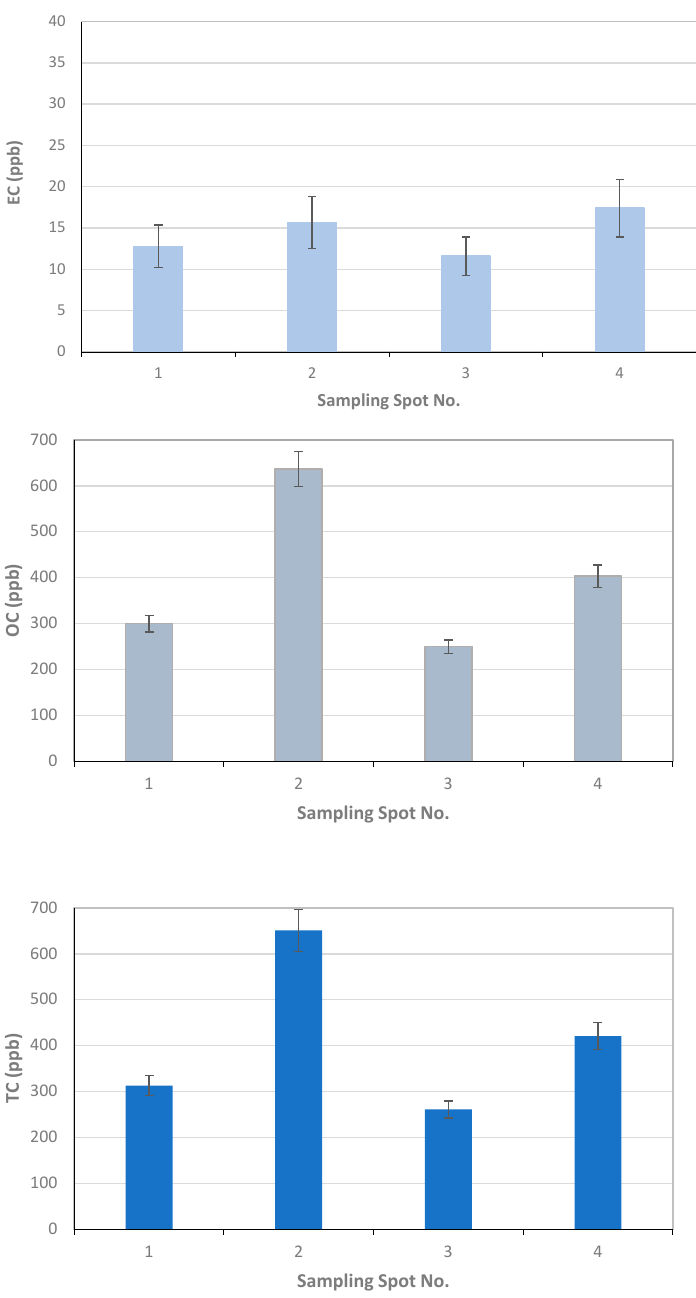
Figure 8. Results of University of Florence for EC, OC, and TC concentrations and associated uncertainties measured in the four sampling locations S1–S4. For the Finnish Meteorological Institute, the results of the EC, OC, and TC analysis as mass of carbon fraction in filter samples as [ μ g/cm 2 ] are reported in Table 3, together with the volume of the filtered snow sample in [ml]. Each filter was used to analyze three replicates marked as a, b, and c. The concentration of the EC, OC, and TC per volume of snow in [ppb] is calculated using the volume of melted snow and the amount of carbon compound in the analyzed filter piece multiplied by the filter area (Figure 9). Table 3. The EC, OC, and TC results of Finnish Meteorological Institute. The analysis uncertainty is ±0.2 μ gC (+5% relative error for higher loaded samples). Sample ID